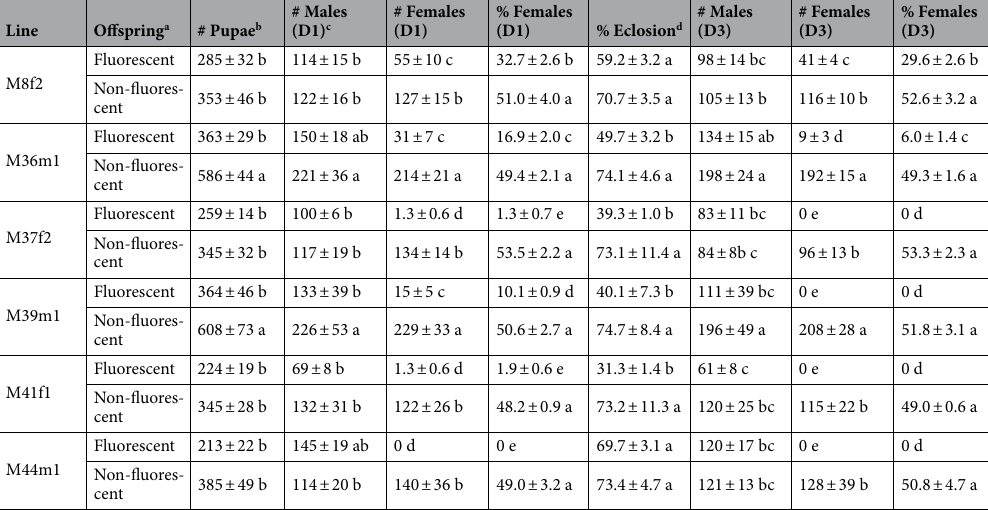
offspring than those from V185_M1m1, V227_M5F1, and V229_M4f1 under restrictive tetracycline conditions ( P < 0.05, One-way ANOVA). In addition, the ratio of female offspring from V229_M4f1 was significantly lower than those from V185_M1m1 and V227_M5F1 ( P < 0.001, One-way ANOVA). As observed for V229_M4f1, we were unable to breed the other V229 lines to homozygosity because homozygous females were non-viable on standard tetracycline diet. To determine whether the unwanted female lethality in the V229 lines was caused by a tetracycline dose insufficient to completely inhibit tTA binding to TRE (100 µg/ml), we tested flies from lines V229_M4f1, V229_M8f2, and V229_M36m1 with different concentrations of tetracycline (250, 500 and 1000 μg/ mL) as well as doxycycline (100, 250 and 500 μg/mL), the latter being more effective than tetracycline for the suppression of tTA-induced lethality 26,33,34 . However, no homozygous adult females were recovered under any of these conditions, suggesting that homozygous females died due to the basal expression of Dshid Ala4 . All V229 lines were therefore maintained by crossing heterozygous flies on standard tetracycline diet in each generation. Staged-lethality tests for V229 lines. To evaluate the FK efficiency of each V229 line, the heterozygous males were crossed with WT females in the absence of tetracycline (Table 2). Half the offspring were expected to be WT with a 1:1 sex ratio, and the other half were expected to be transgenic flies (heterozygous) with a strongly male-biased sex ratio. Indeed, all crosses produced similar numbers of WT males and females (female percentages ranged between 48.1 and 53.4%, P > 0.05, One-way ANOVA), and the eclosion rates of WT flies were not significantly different in the range of 70.4–75.0% ( P > 0.05, One-way ANOVA, Table 2). As expected, a considerably lower female ratio of transgenic flies (fluorescent) was produced compared to that of WT flies in each cross ( P < 0.05, One-way ANOVA). For example, crosses of the three lines M37f2, M39m1, and M41f1 generated transgenic offspring with only 1.3%, 10.2%, and 1.9% females, respectively. Females died within three days after emergence (Table 2). The eclosion rates of transgenic flies from these crosses were 39.9%, 40.6%, and 31.3%, respectively, which was significantly lower than those of WT flies ( P < 0.05, One-way ANOVA), suggest- ing that most females died at the pupal stage. Notably, crosses to M44m1 individuals produced only transgenic males on emergence day and the eclosion rates of transgenic (69.8%) and WT (73.8%) flies were not significantly different ( P > 0.05), suggesting that females died before the pupal stage (Table 2). In addition, the number of emerged WT and transgenic male offspring that survived until the end of day 1 or day 3 was significantly differ- ent from the M39m1 cross ( P < 0.05, One-way ANOVA), indicating a deleterious effect of the transgene on the males in this line. To pinpoint the developmental stage of lethality in females, we carried out staged lethality tests in the absence of tetracycline by backcrossing the M4f1 and M44m1 lines individually to WT flies resulting in a strong FK effect (Fig. 2). From 3500 eggs each, 3228 WT and 3351 V229_M4f1 first-instar larvae were counted (no significant difference in the survival rate, P > 0.05, One-way ANOVA), indicating that V229_M4f1 females did not die during embryogenesis. Counted numbers of third-instar larvae, pupae and adult males from line V229_M4f1 were lower than those from WT, but not significantly different ( P > 0.05, One-way ANOVA), but far fewer adult females (110) were generated from this line compared to WT (895) suggesting that V229_M4f1 females died at the pupal stage ( P < 0.001, One-way ANOVA). In contrast, line V229_M44m1 produced 1421 first-instar larvae,